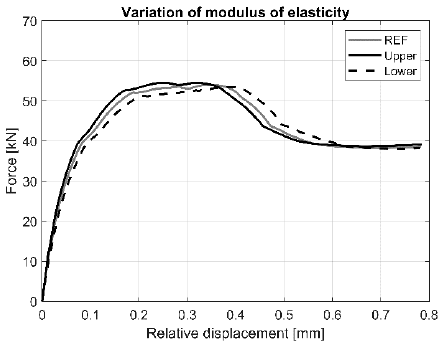
Figure 12. Load vs. load-relative displacement curves for the variation of elastic modulus of AAC.